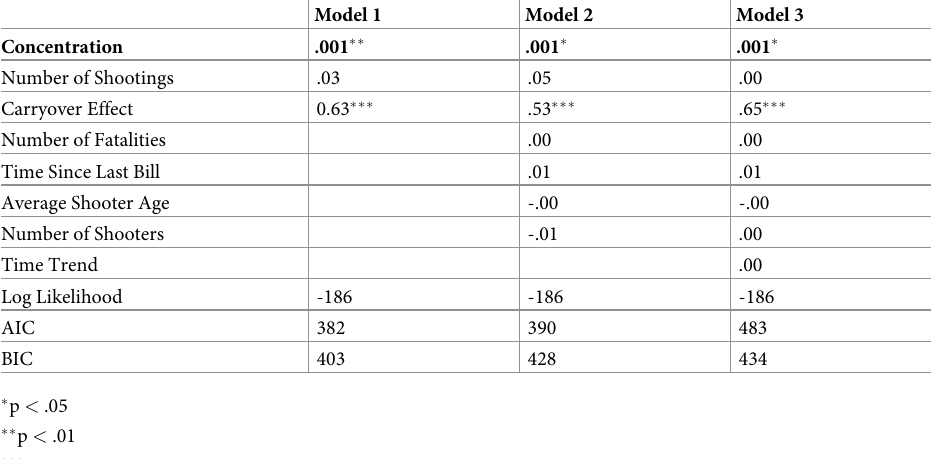
Table 2. Concentration of mass shootings and gun control bills passed into